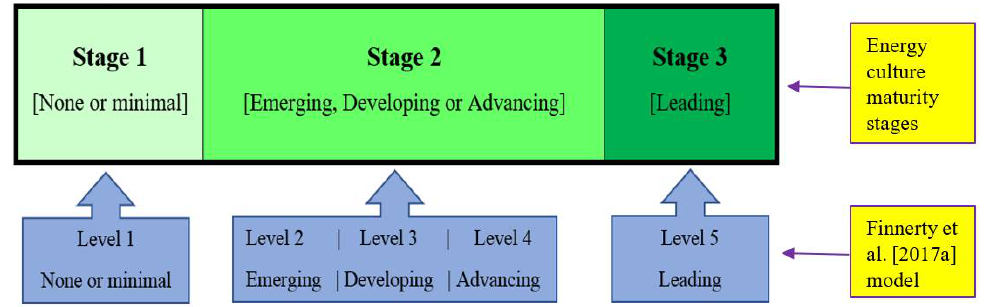
Figure 5. Development of maturity stages (Source: Author developed based on Finnerty et al. [56]).